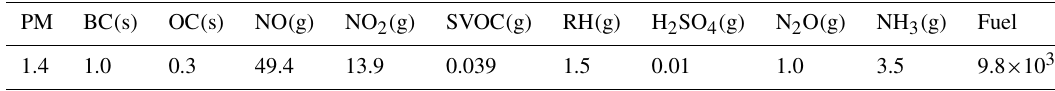
Table 3. Unit emission factors for traffic combustion (s is solid and g is gaseous) on 9 June between 07:00 and 08:00LT in units of 10 − 5 gm − 1 vehicle − 1 . Abbreviations: PM is the total mass of particulate matter, BC is black carbon, OC is organic carbon, NO is ni- trous oxide, NO 2 is nitrous dioxide, SVOC is semi-volatile organic carbon, RH is alkanes, H 2 SO 4 is sulfuric acid, N 2 O is nitrous oxide, and NH 3 is